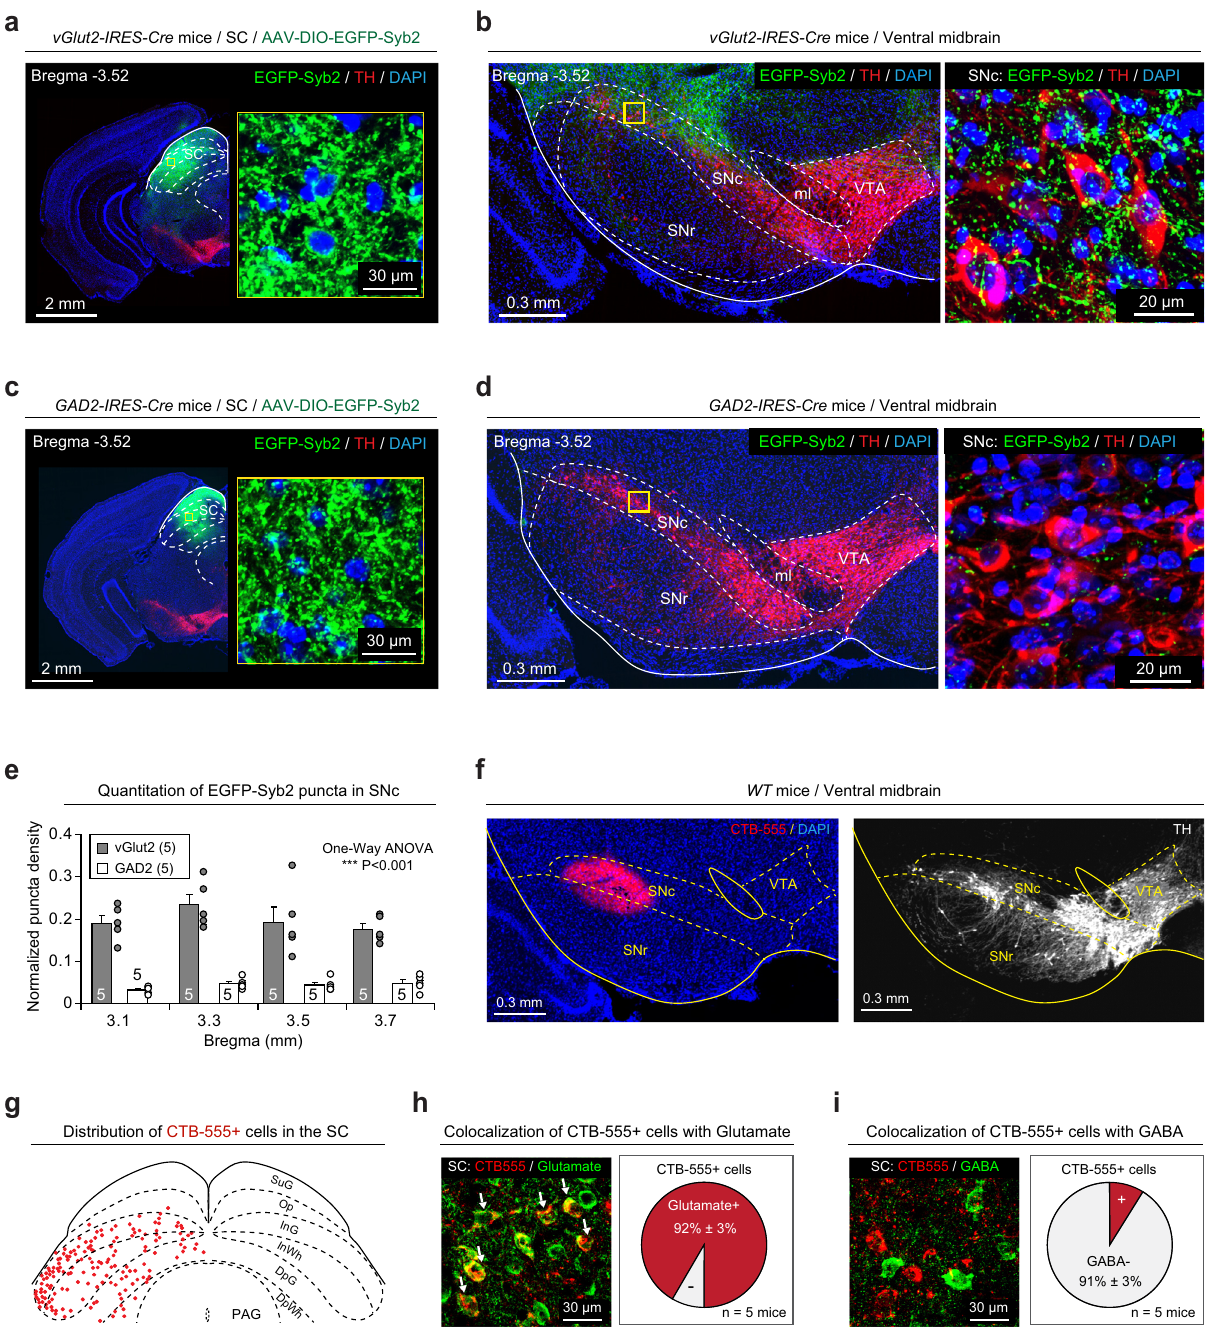
Fig. 1 Cell-type-speci fi c mapping of the SC – SNc pathway. a , c Example coronal brain sections of vGlut2-IRES-Cre ( a ) and GAD2-IRES-Cre mice ( c ) with EGFP-Syb2 expression in the SC. Insets, high-magni fi cation micrographs showing EGFP-Syb2 + puncta in the SC. b , d Left, EGFP-Syb2 + axon terminals in the ventral midbrain of vGlut2-IRES-Cre ( b ) or GAD2-IRES-Cre mice ( d ). Right, high-magni fi cation micrographs showing EGFP-Syb2 + puncta (green) in the SNc. The boundary of the SNc was delineated according to the immuno fl uorescence of TH (red). e Normalized density of EGFP-Syb2 + puncta in the SNc of vGlut2-IRES-Cre (vGlut2) and GAD2-IRES-Cre (GAD2) mice as a function of bregma. The normalization was made by dividing the puncta density in the SNc with that in the SC. f Example coronal section of ventral midbrain showing the injection of CTB-555 into the SNc of WT mice (left). The boundaries of SNc and VTA were determined by immuno fl uorescence of TH of dopamine neurons (right). This experiment was repeated independently in fi ve mice with similar results. g A schematic diagram showing the distribution of SNc-projecting SC neurons that were labeled by CTB-555. h , i Example micrographs (left) and quantitative analyses (right) showing CTB-555 + cells in the SC are predominantly positive for glutamate ( h ) and negative for GABA ( i ). Number of mice was indicated in the graphs ( e, h, i ). Data in e, h , i are means ± SEM (error bars). Statistical analyses in e were performed by one-way ANOVA (*** P < 0.001). Scale bars are indicated in the